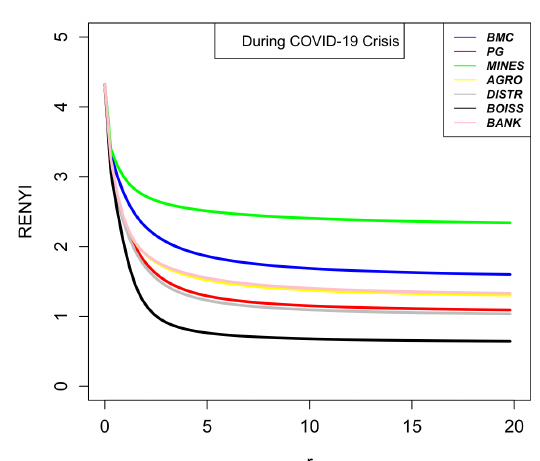
Figure 7. Rényi entropy (Hr) versus scale r for BOISS